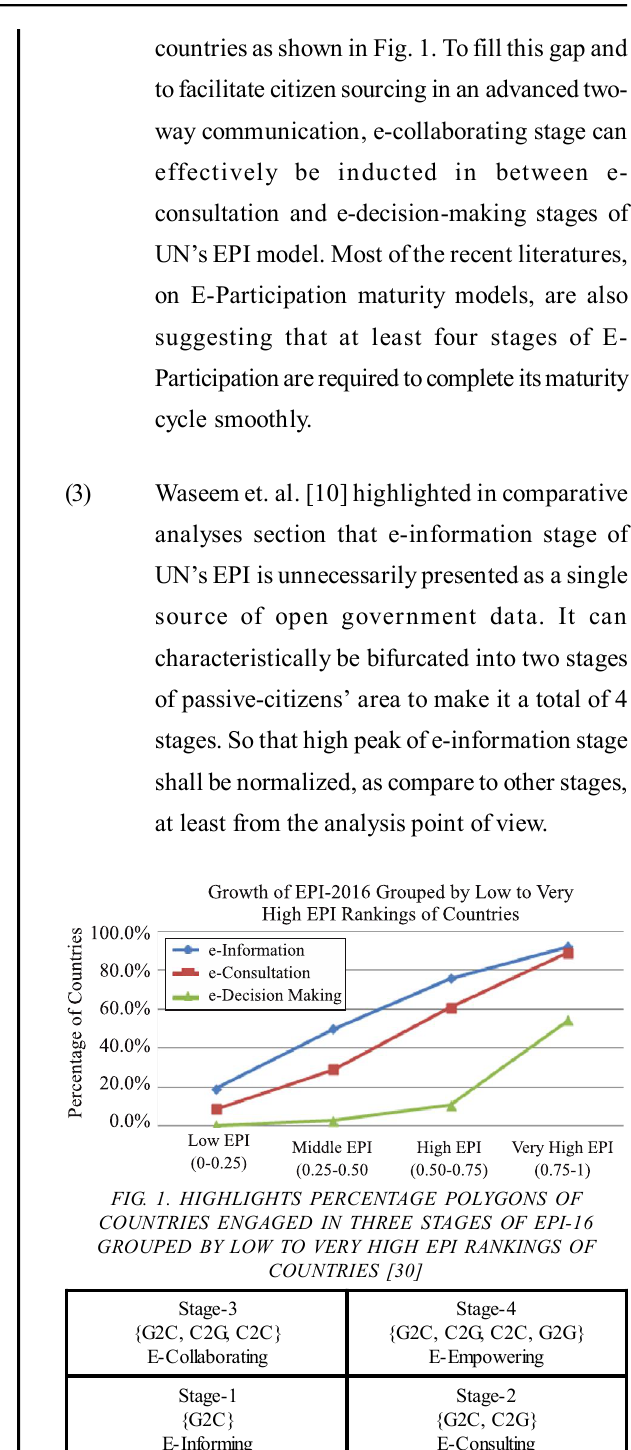
FIG. 1. HIGHLIGHTS PERCENTAGE POLYGONS OF COUNTRIES ENGAGED IN THREE STAGES OF EPI-16 GROUPED BY LOW TO VERY HIGH EPI RANKINGS OF COUNTRIES [30] Stage-3 {G2C, C2G, C2C}